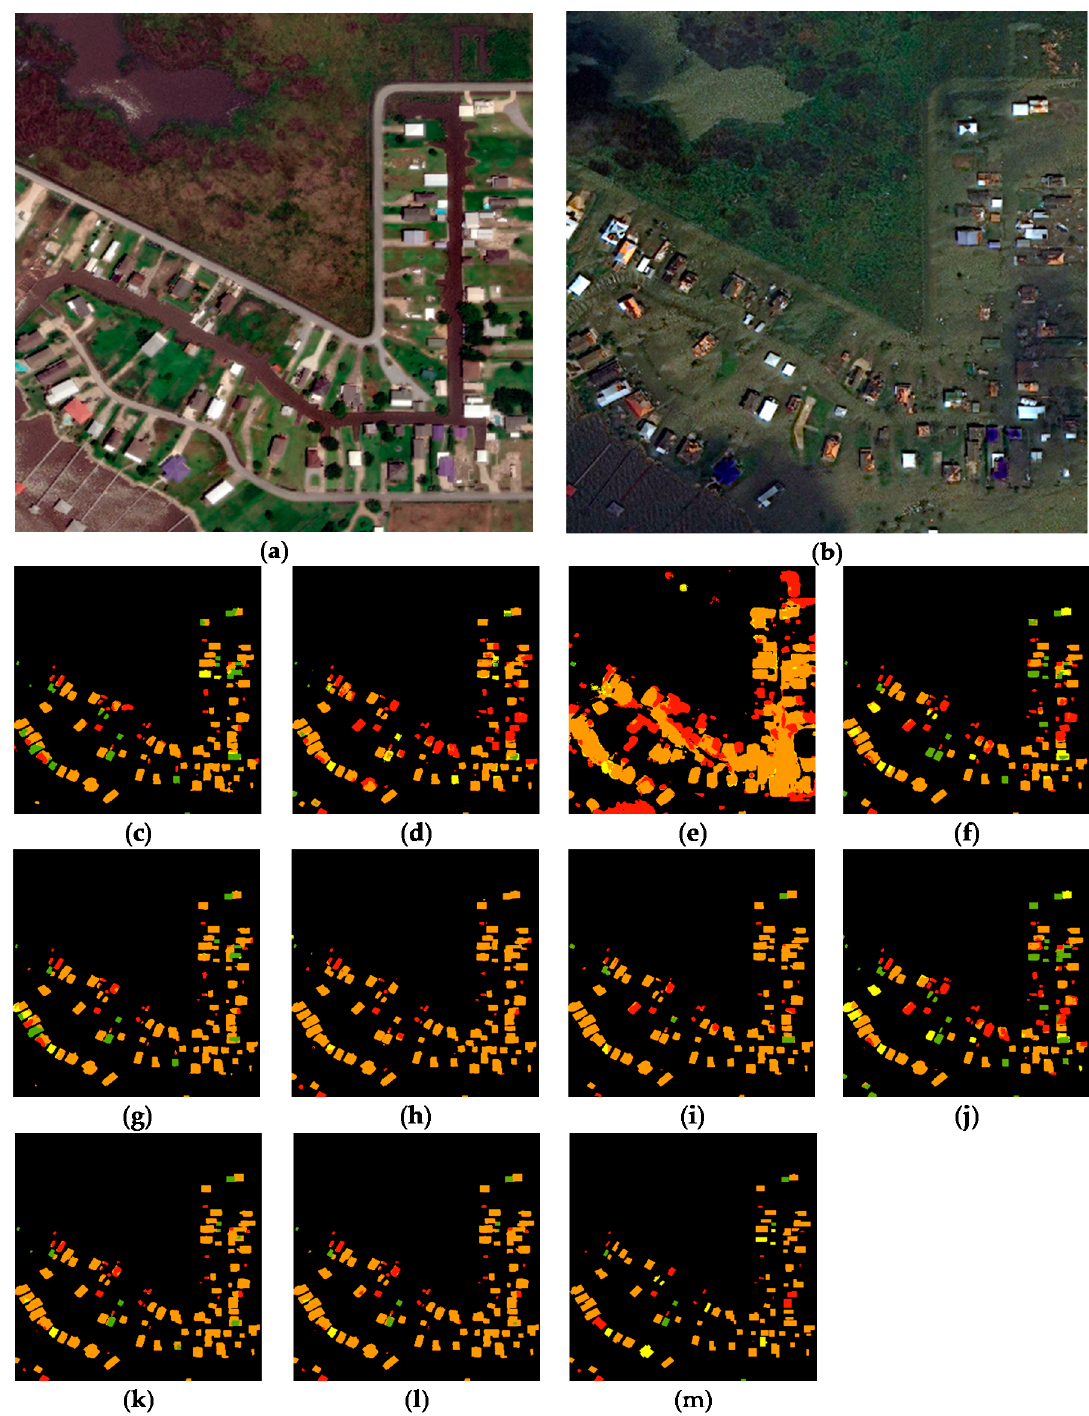
Figure 15. Hurricane Laura interest area 1. ( a ) A pre-disaster image, ( b ) a post-disaster image and ( m ) is the GT. ( c ) The result of ResNet (w/o A), ( d ) the result of SEresNeXt (w/o A), ( e ) the result of DPN (w/o A), ( f ) the result of SENet (w/o A), ( g ) the result of ResNet (w A), ( h ) the result of SEresNeXt (w A), ( i ) the result of DPN (w A), ( j ) the result of SENet (w A), ( k ) the fusion result without the attention mechanism and ( l ) the fusion result with the attention